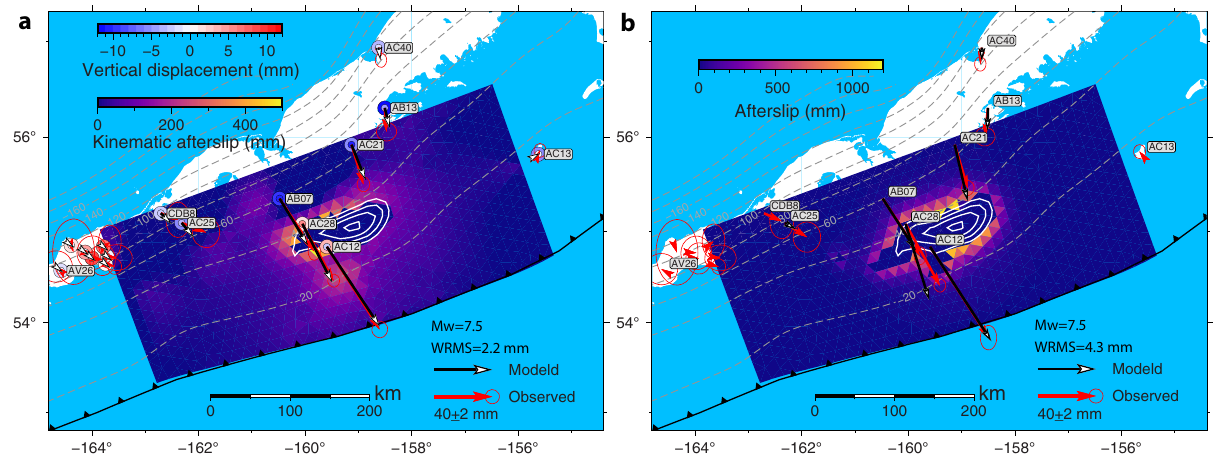
Fig. 3 Kinematic afterslip model and stress-driven afterslip model. a Cumulative afterslip distribution in the fi rst 87 days inverted from Global Positioning System (GPS) postseismic transients. The weighted root-mean-square (WRMS) mis fi t for this kinematic model is 2.2 mm. White lines represent the contours of coseismic slip distribution of the 2020 Simeonof earthquake. Afterslip is not allowed within the ∼ 1.0 m slip contour of the coseismic rupture. Dashed gray lines depict the depth contours from the Slab2 model 65 . b Stress-driven, frictional afterslip in the fi rst 87 days (WRMS = 4.3 mm) with the optimal constitutive parameters based on the third scenario (afterslip on velocity-strengthening megathrust surrounding the coseismic rupture). Note the different color scales in the stress-driven vs. kinematic afterslip models.